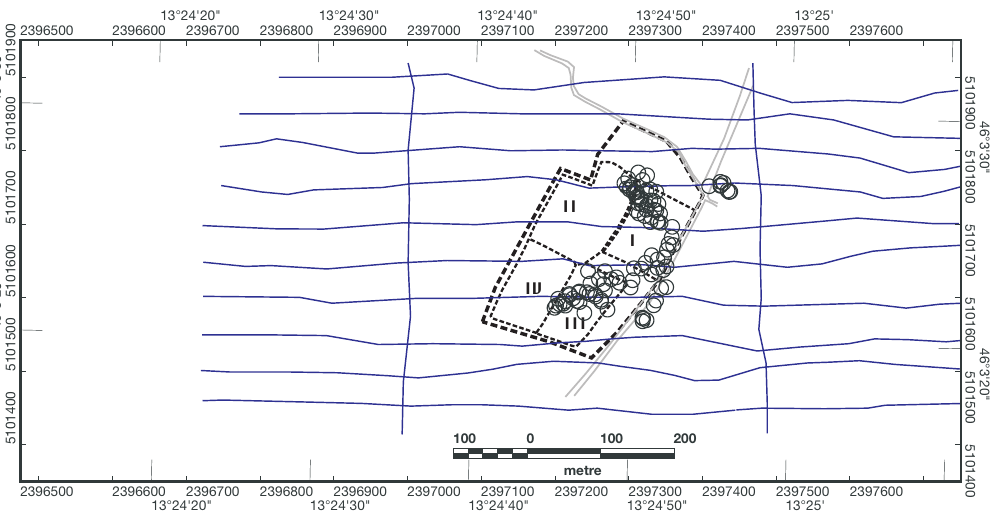
Fig. 8. Three dimensional Euler deconvolution map over the waste site area. Note clustering of Euler solutions in area I and III of the waste site. A single depth solution range of 80-90 m is